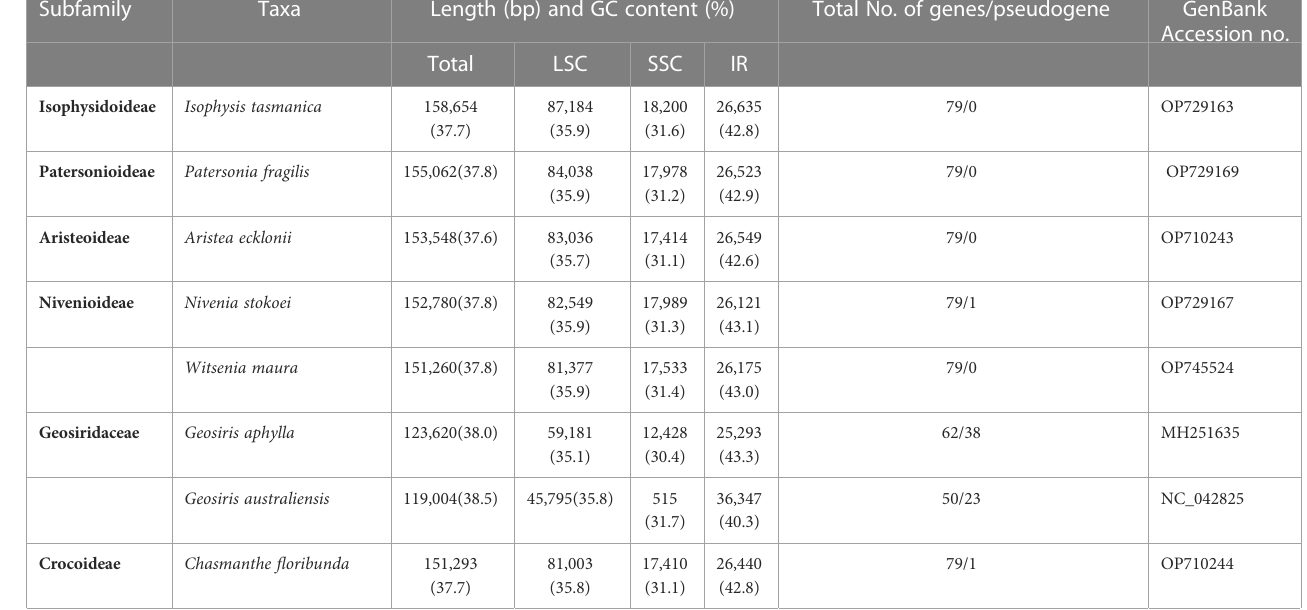
TABLE 2 Comparison of the features of plastomes from representative taxa of Iridaceae. Subfamily Taxa Length (bp) and GC content (%) Total No. of genes/pseudogene GenBank